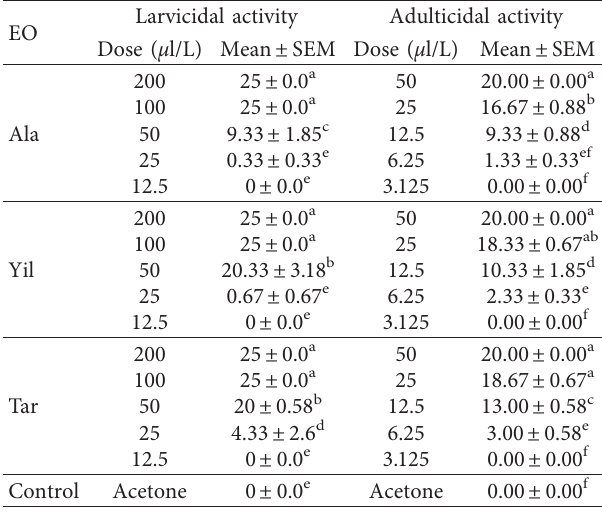
Table 1: ANOVA result of the mean number of larval ( n � 25) and adult ( n � 20) deaths due to Ala, Yil, and Tar EOs.